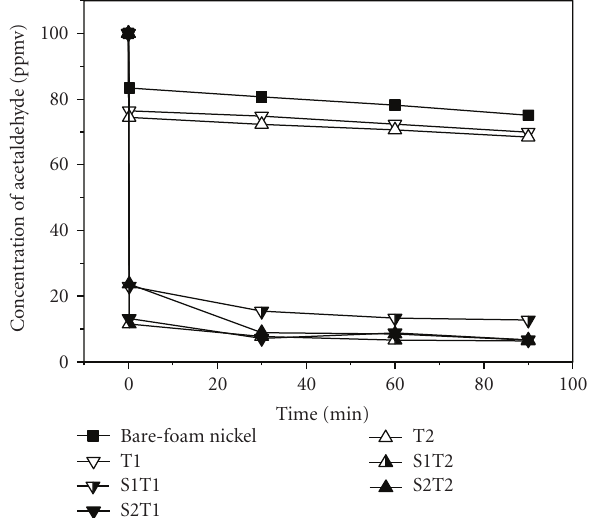
Figure 7: Time courses of concentrations of gaseous acetaldehyde caused by adsorption on bare-foam nickel, T1, T2, S1T1, S1T2, S2T1, and